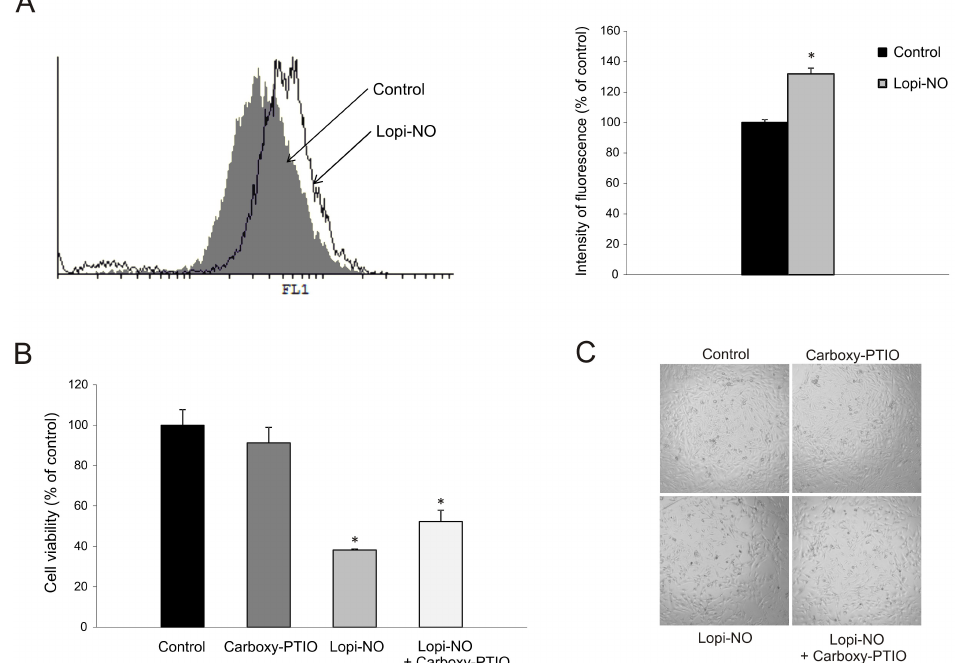
Figure 5. Lopi-NO induced reactive oxygen species (ROS)/reactive nitrogen species (RNS) production in U-251 cells. ( A ) Before treatment with IC 50 dose of Lopi-NO for 48 h, cells were subjected to dihydrorhodamin 123 (DHR) staining and analyzed by flow cytometry. One representative histogram (left) and chart of three independent experiments (right) are shown. Cells were treated with Lopi-NO and/or carboxy-PTIO (20 µ M) for 48 h and subjected to ( B ) CV staining and ( C ) light microscopy (magnification 40 × ). Data are presented as mean ± SD of three independent experiments. * p < 0.05 compared to untreated cultures.